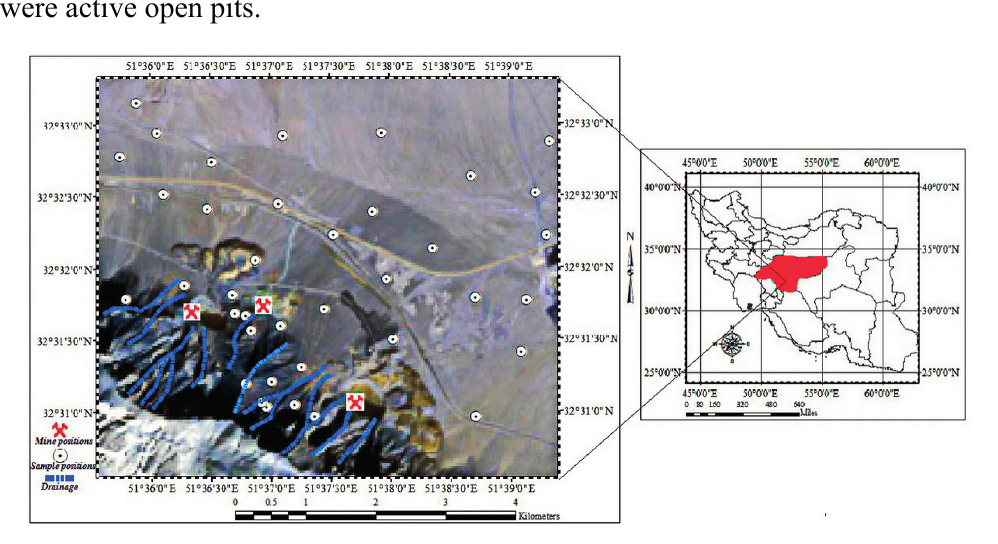
Figure 2. Location of the case study area (Irankouh